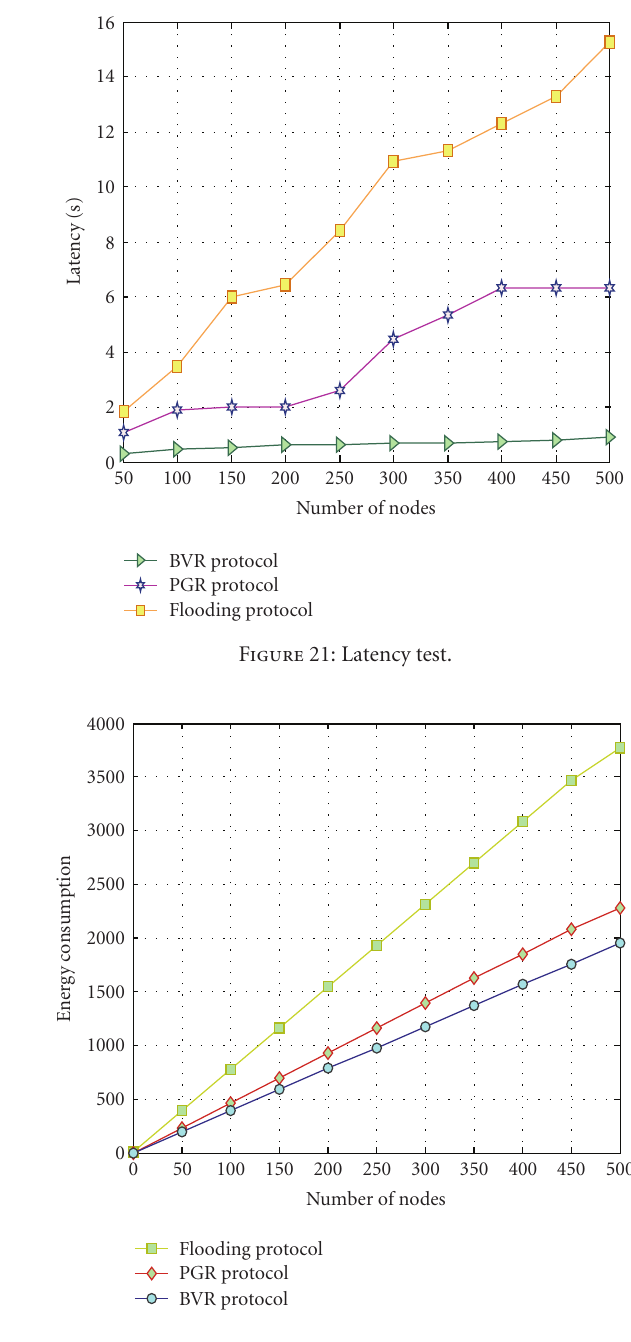
Figure 22: The energy consumption